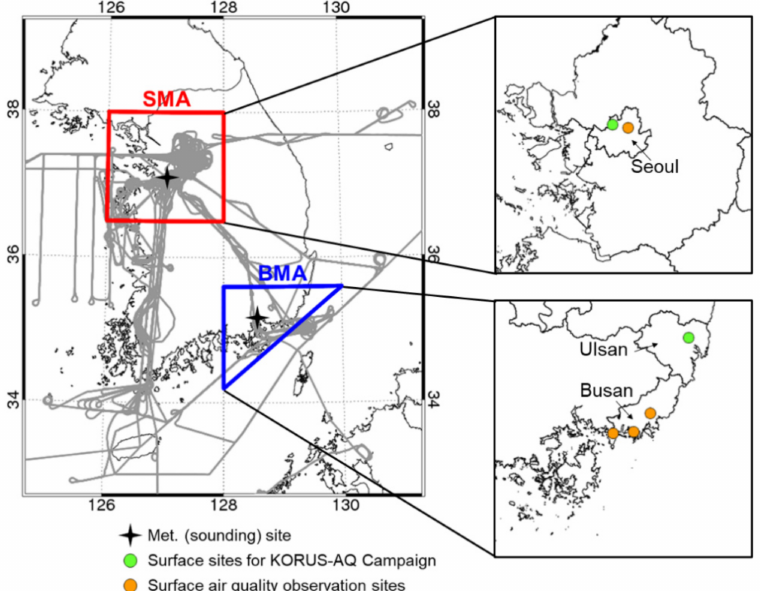
Figure 1. DC-8 flight pathways during the KORUS-AQ campaign, the domains of SMA (Seoul metropolitan area) and BMA (Busan-containing metropolitan area), and the locations of monitoring and sounding meteorological stations for SMA and BMA within South Korea. Gray lines indicate flight pathways during